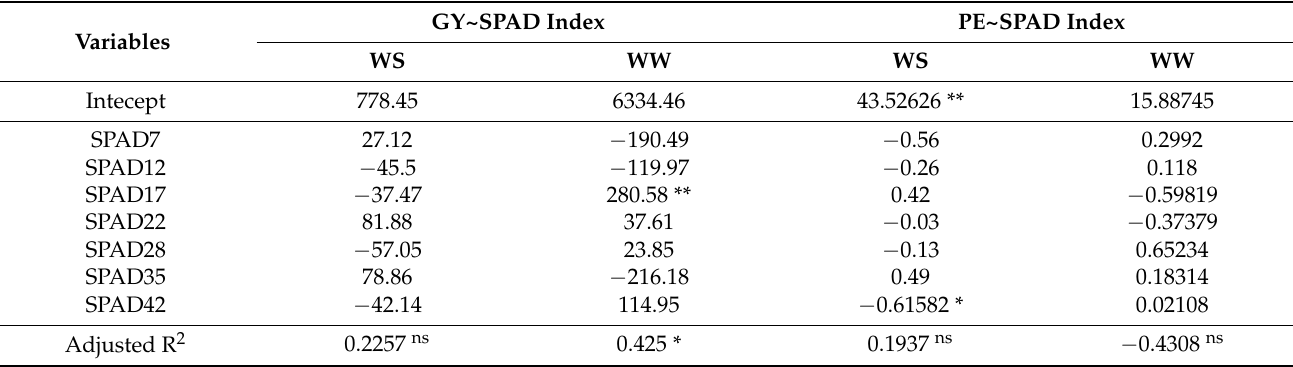
Table 3. Estimated beta values using multiple regression based on seven predictors of the SPAD index (measured 7, 12, 17, 22, 28, 35 and 42 days after male flowering) versus the dependent variables grain yield (GY) and popping expansion (PE) evaluated in 20 popcorn inbred lines under two water conditions